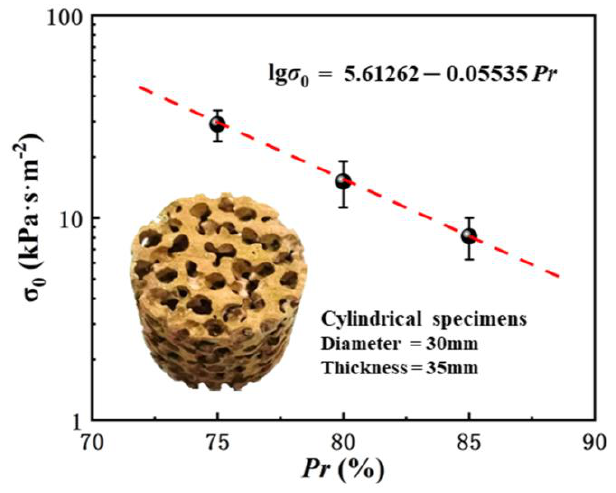
Figure 11. Airflow resistivity of OCCF with different porosity.